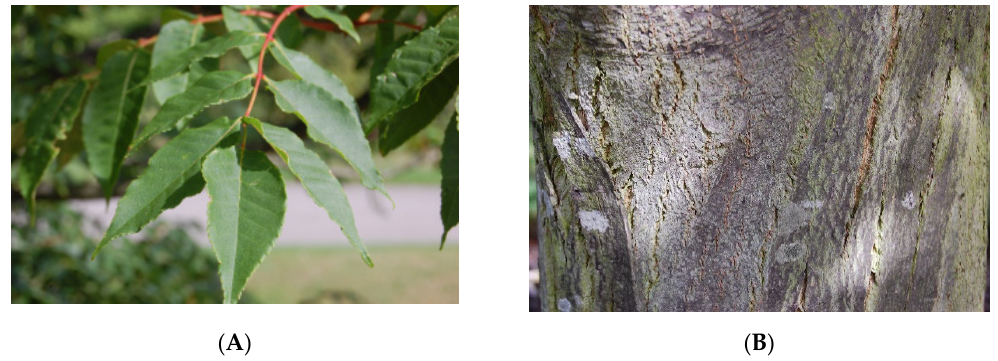
Figure 1. Close ‐ up image of Picrasma quassioides (D. Don) Bennett tree: ( A ) leaves ( B )wood bark. The Figure 1. Close-up image of Picrasma quassioides (D.Don) Bennett tree: ( A ) leaves ( B )wood bark. images were obtained from Reference [11] with permission. The images were obtained from Reference [11] with